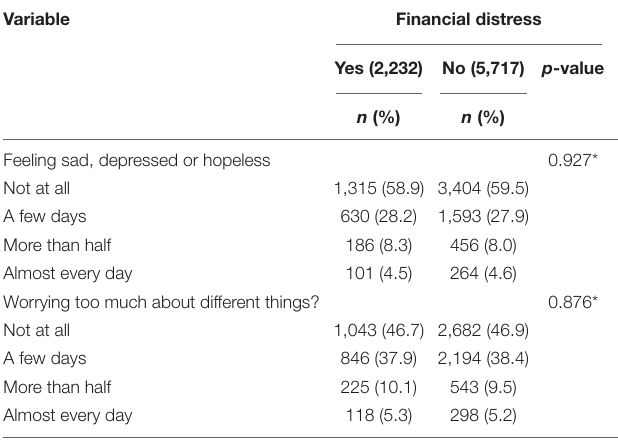
TABLE 9 | Overview of mental health during a pandemic based on financial conditions.